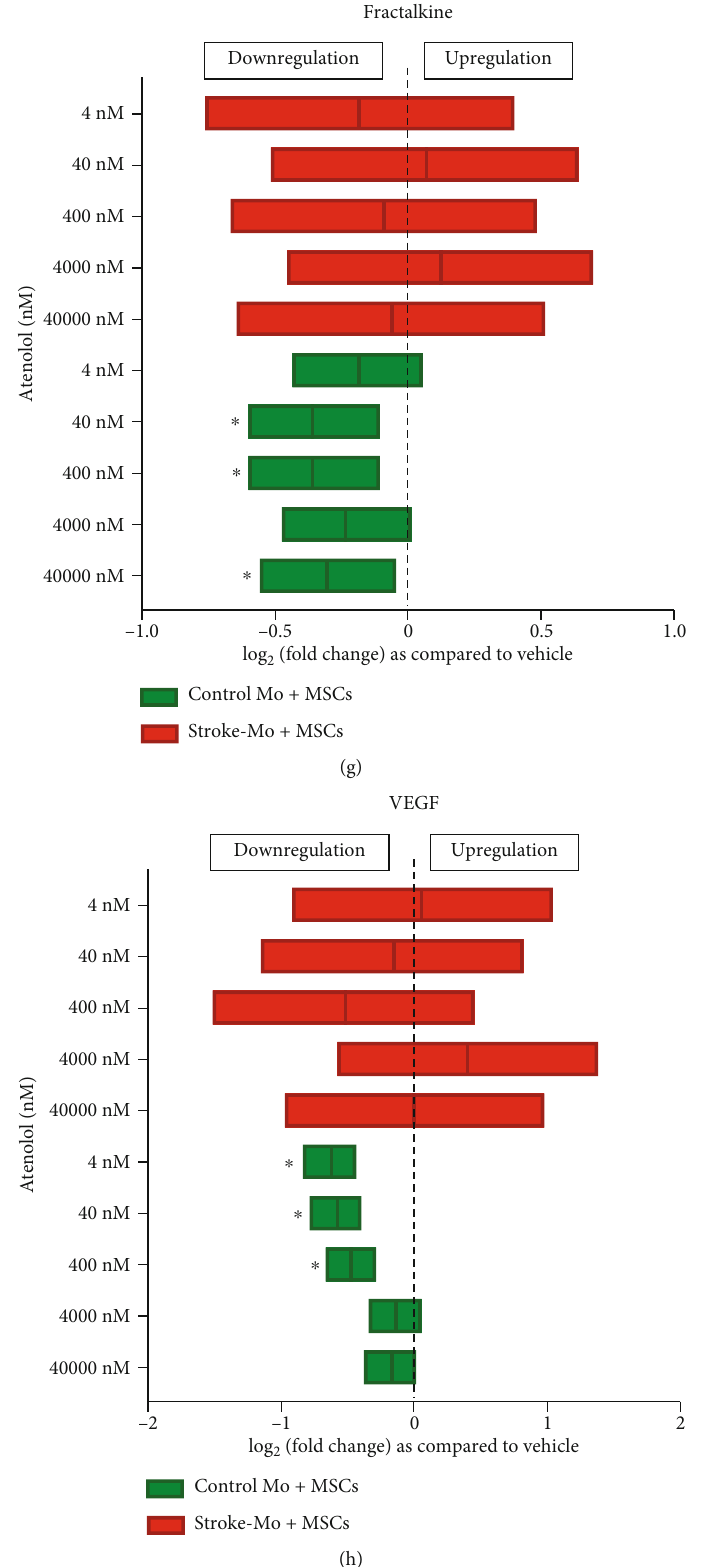
Figure 3: Atenolol reduces the cytokine secretions of IL-1 β , IL-8, MCP-1, TNF- α , IL-IRA, IL-6, Fractalkine, and VEGF from cocultures of healthy control monocytes with MSCs after 24 hours of exposure but does not alter any cytokine secretions from cocultures involving stroke patient-derived monocytes. Signi fi cance is shown by ∗ p < 0 : 05 . All fold changes are as compared to vehicle